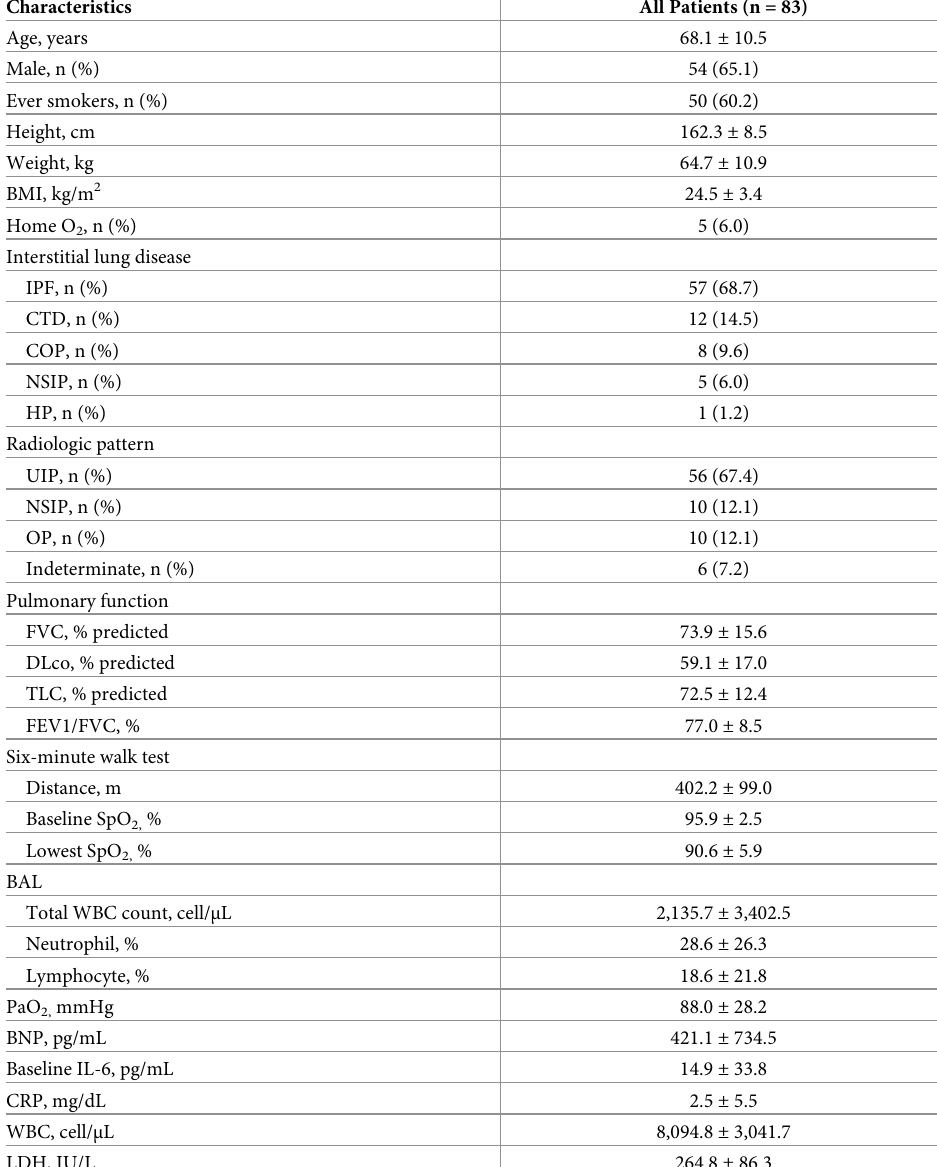
Table 1. Baseline clinical characteristics of the